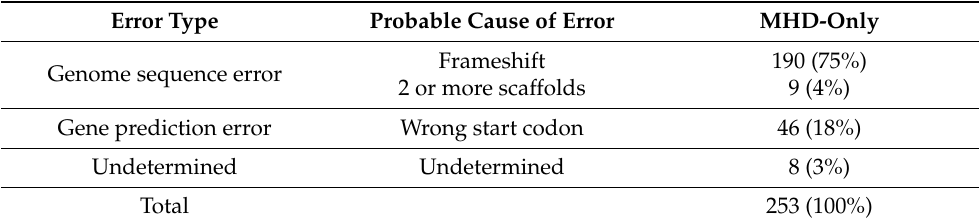
Table 2. Probable sources of protein sequence prediction errors in the SGD